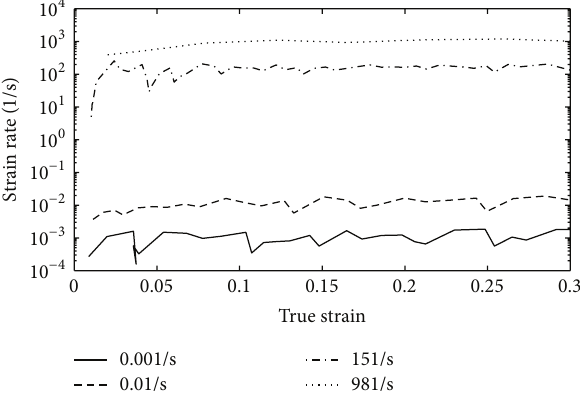
Figure 7: Volume change at several strain rates.